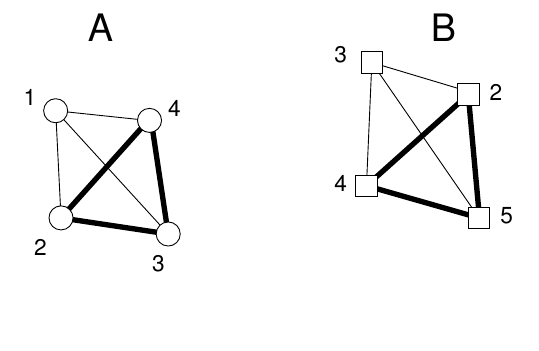
Figure 2. Schematic of situation in Step 2 after identification of matching cliques. The distance differences not yet investigated in the previous step are tested for fulfillment of − D | , | D − D | , | D − D | , the differ- inequality 3. Here, these are | D A, 23 B, 45 A, 34 B, 52 A, 24 B, 42 ences of the lengths of the corresponding bold edges. After having passed this test it is guaranteed that all corresponding edges of the two complete graphs (cliques) have distance differences of δ or less. The stars around a and b in Figure 1 have not passed the test and 2 6 7 have been